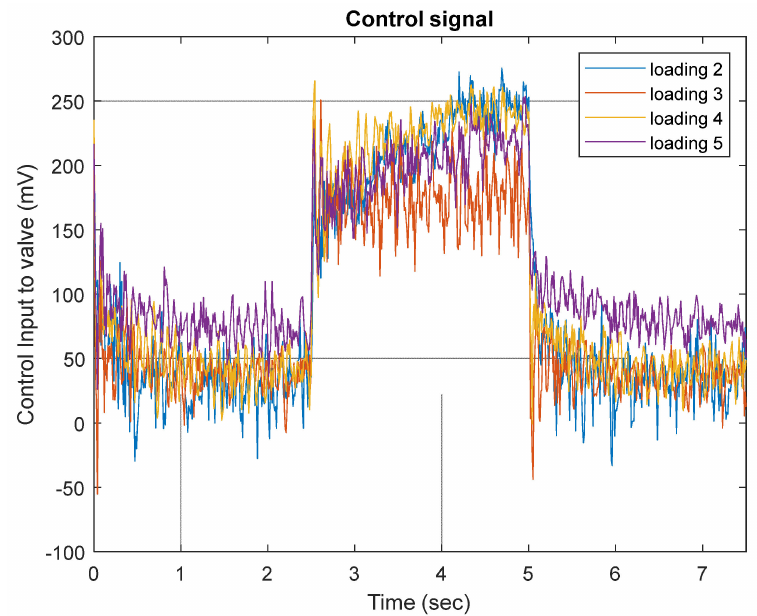
Figure 18. Evaluated control